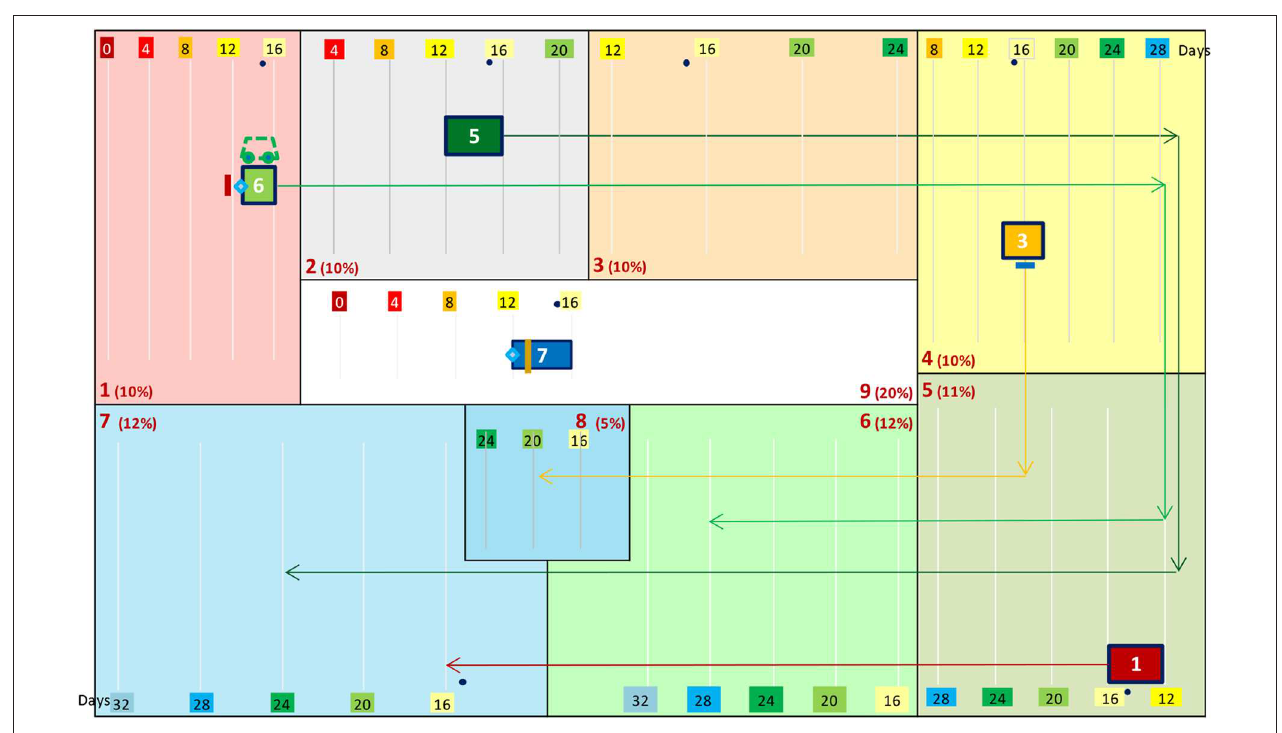
FIGURE 4 | Site-spatial-temporal modeling current work.